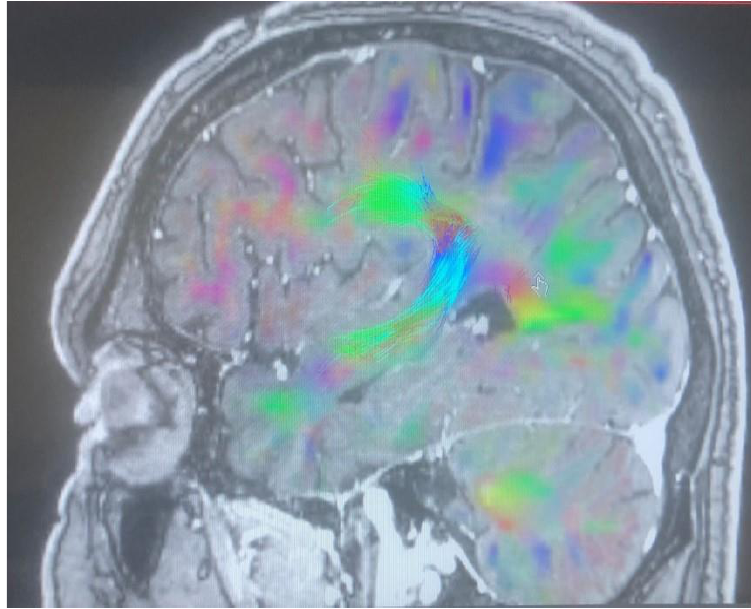
Figure 4. Arcuate fasciculus before cingulotomy.